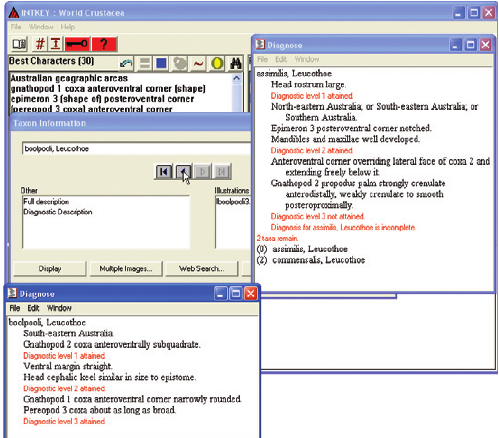
Figure 57. Diagnostic descriptions of two species where the diagnostic level has been raised to a value of ‘ 3 ’.